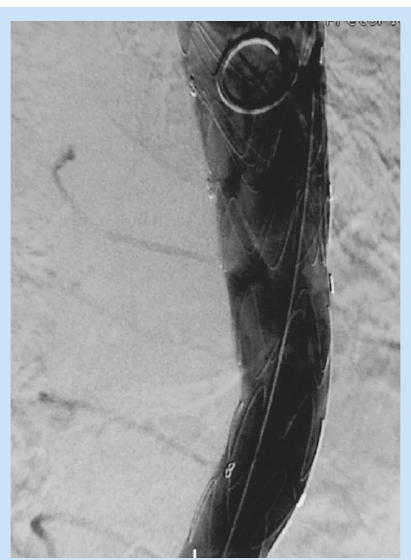
Fig. 2b. After coverage of the entry site with a stent graft device.